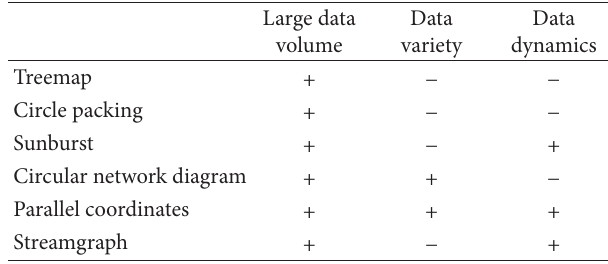
Table 1: Properties of visualization methods.